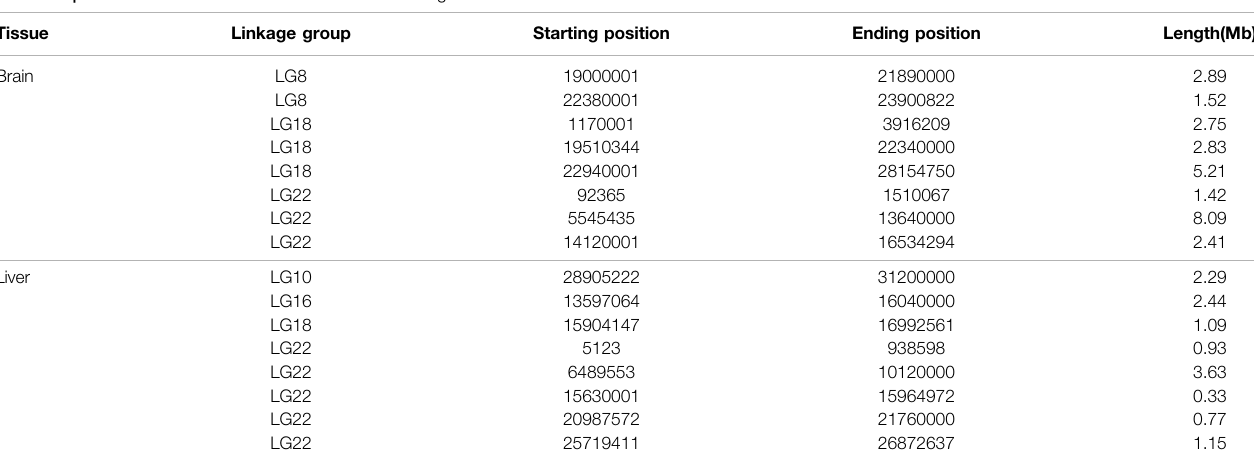
TABLE 3 | Statistical results of brain and liver candidate